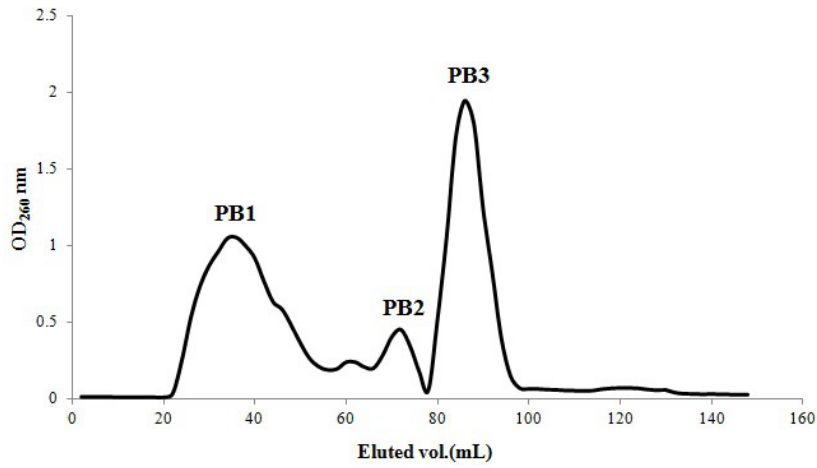
Figure 2. Elution profile of PB from Sephadex